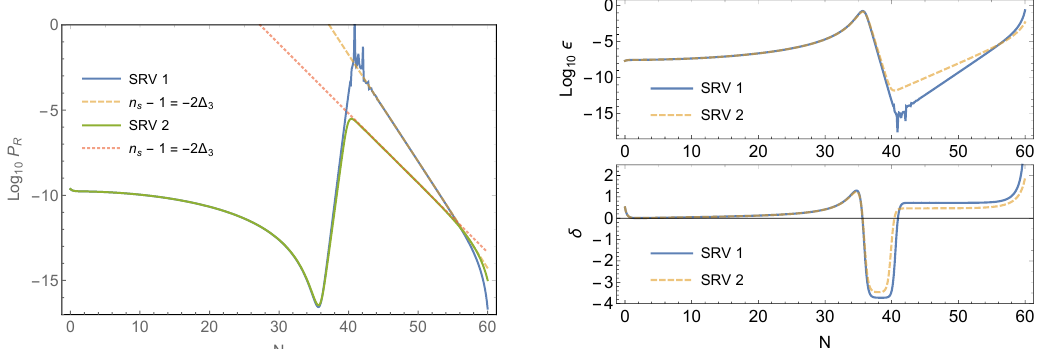
Figure 5 . The power spectrum P R of the slow-roll-violating (SRV) class with the transition from δ < 0 to δ > 0 . H ∗ = 10 − 8 M pl is used in this plot. The evolution of δ from negative to positive values is constrained by the continuity of the scaling dimension (conformal weight) ∆ . The dotted lines are fitted power spectra with the spectral index given by n s − 1 = − 2∆ 3 , where ∆ 3 = ∆( N = 50) is